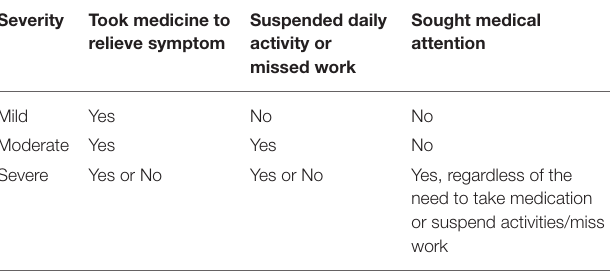
TABLE 1 | Severity categorization. Severity Took medicine to Suspended daily relieve symptom activity